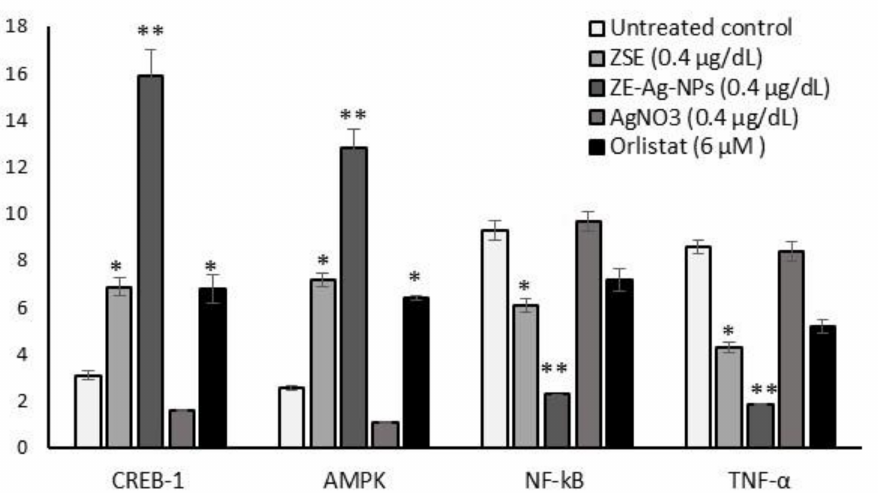
Figure 6. Quantification of adipocyte oxidative metabolism and metabolic inflammation-related protein levels in ZSE, AgNO 3 , ZS-Ag-NPs and orlistat treated maturing adipocytes (14 days)) using the ELISA method. Each value is a mean ± SD ( n = 6). * significant at p ≤ 0.05 and ** highly significant at p ≤ 0.001, by comparison with the vehicle